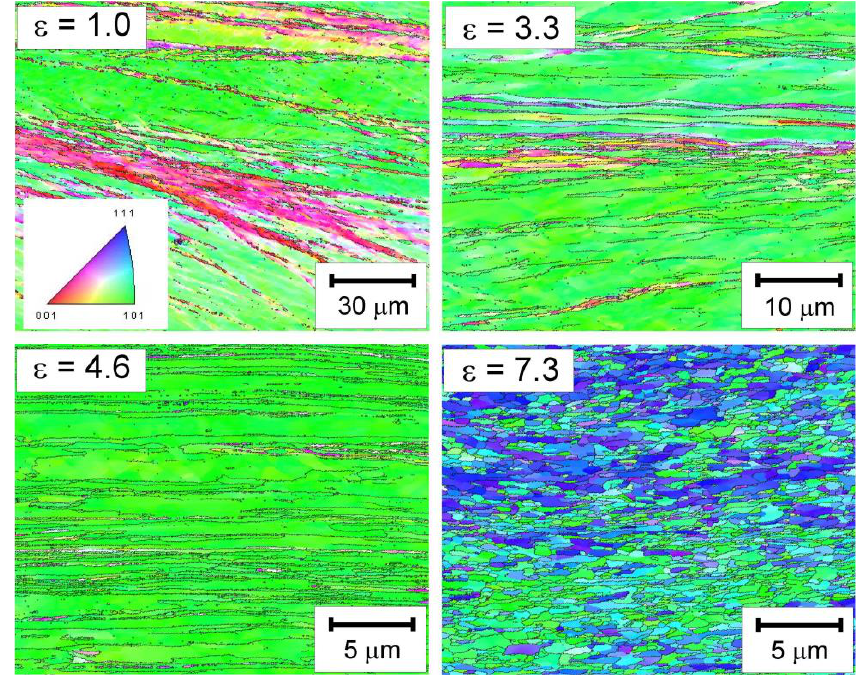
Figure 21. OIM images of a Fe-15%Cr stainless steel processed by bar rolling/swaging to the total indicated strains Reproduced from [96] with permission from Elsevier, 2023. Grain boundaries are indicated by black lines. The colors reflect the crystallographic direction along the rolling/swaging axis that is horizontal in the micrographs.